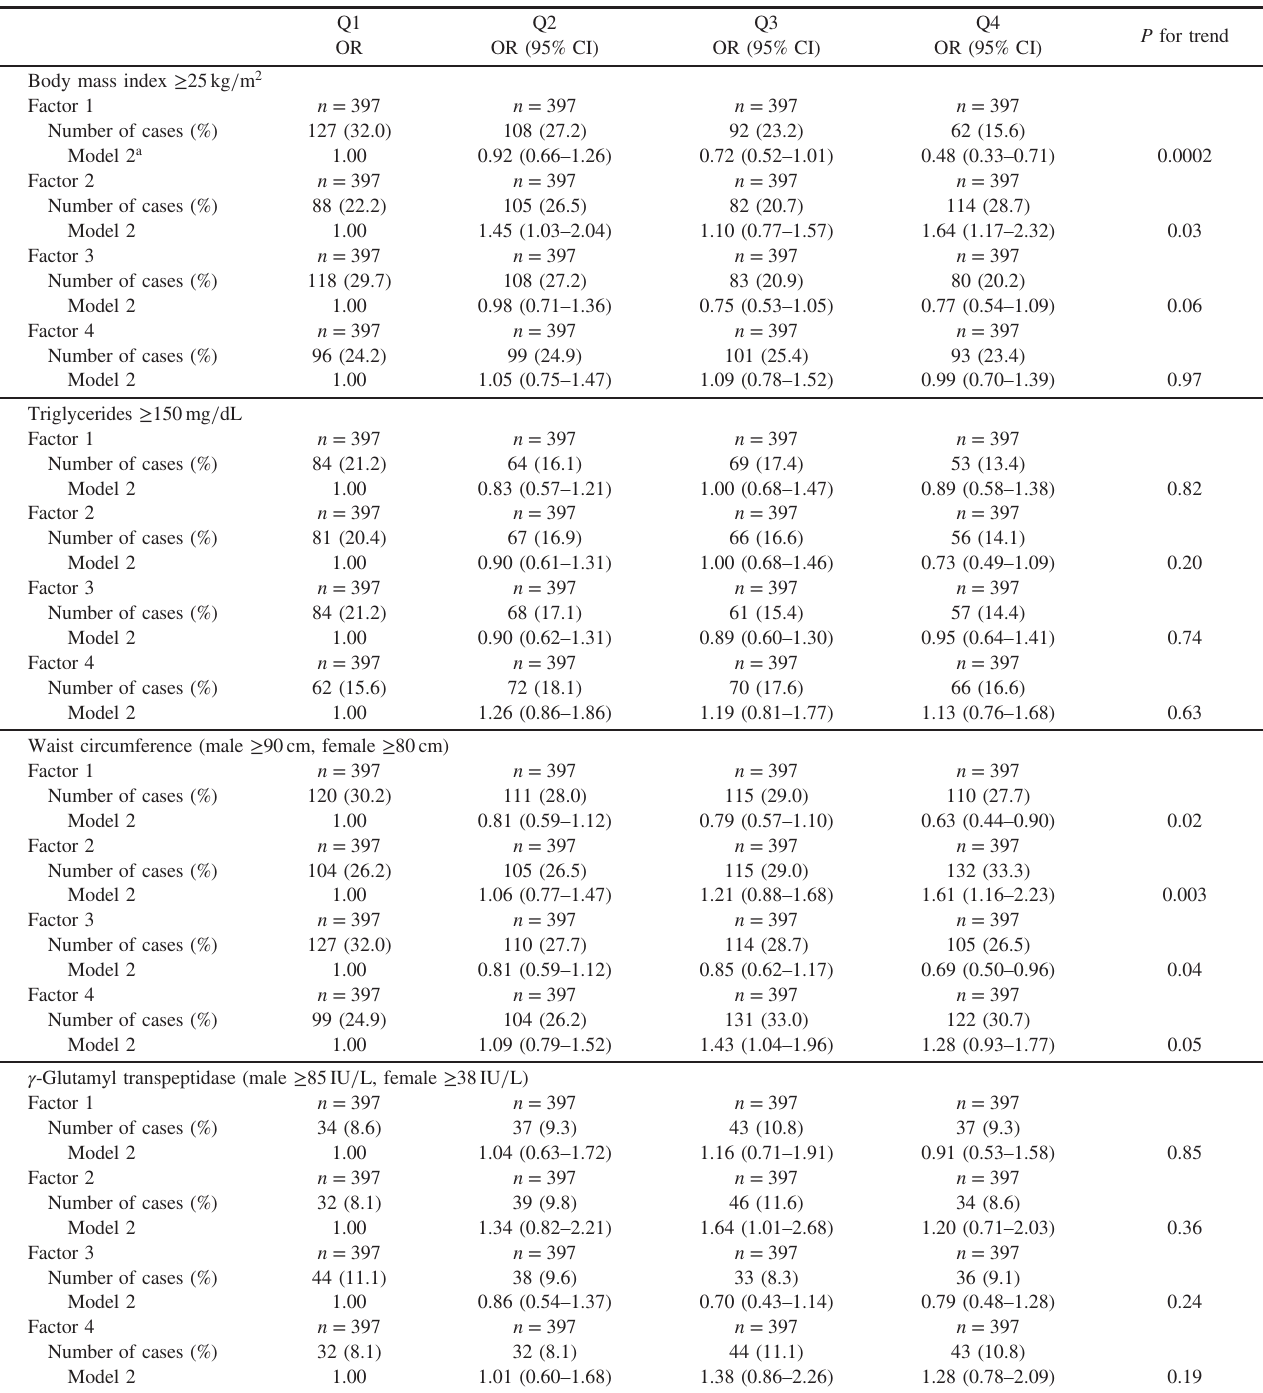
Table 4. Associations of four factor scores with each Fatty Liver Index component Q1